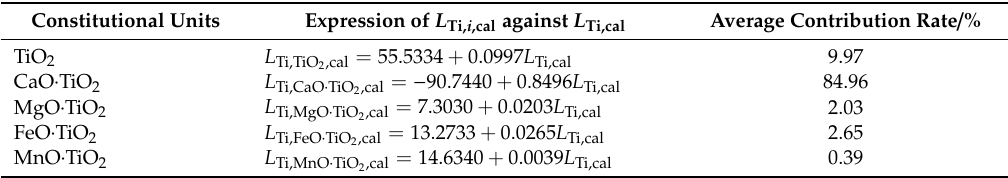
Table 5. Linear regression expression of L Ti, i ,cal against L Ti,cal for the structural units containing TiO 2 and their average contribution rates to L Ti,cal based on